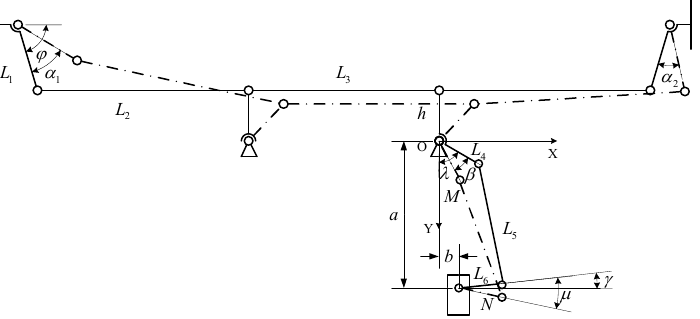
Figure 8. A Schematic diagram of the simplified two-round Figure 8. The steering gear controls the steering mechanism movement.